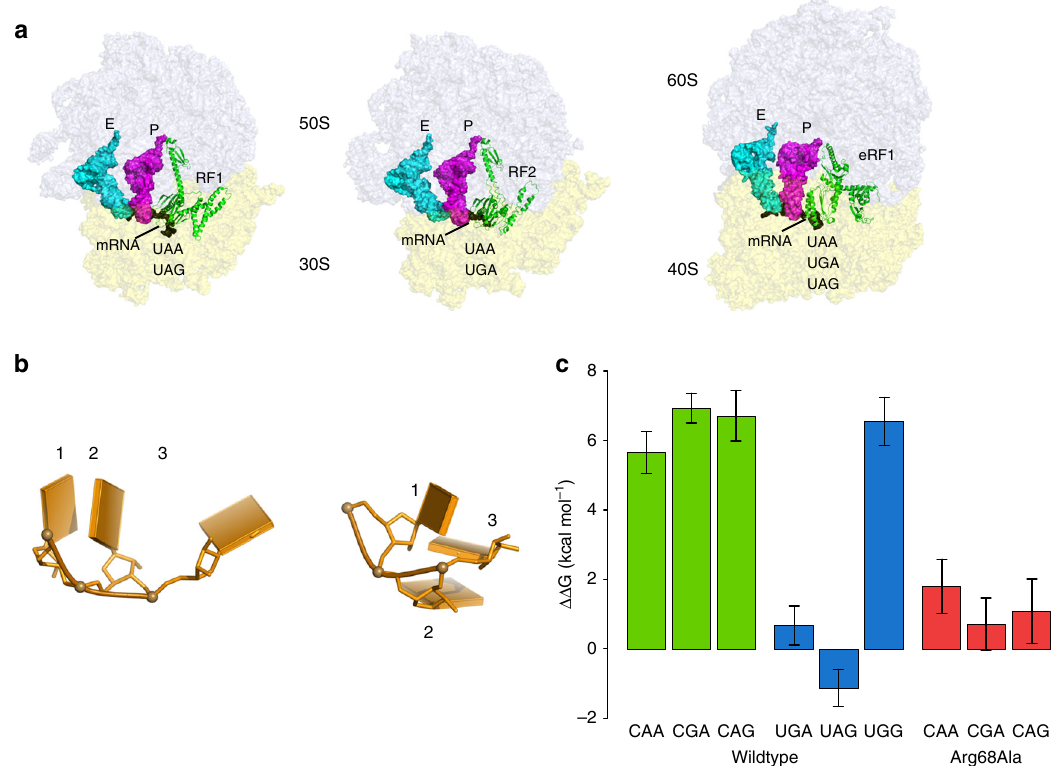
Fig. 1 Stop codon recognition in bacteria and eukaryotes. a View of bacterial (RF1 and RF2) and eukaryotic release factors (eRF1) bound to their respective ribosomes. The latter is omnipotent and reads all three stop codons. b The mRNA stop codon conformation is different in bacteria (left) and eukaryotes (right), where the latter is characterized by an mRNA U-turn. c Calculated binding free energy changes associated with single mutations from cognate to near-cognate stop codons (green and red bars for wildtype and mutant eRF1, respectively) and the corresponding binding free energies for the UGA, UAG, and UGG codon relative to UAA (blue bars). Error bars, 1 s.e.m. from at least 15 independent